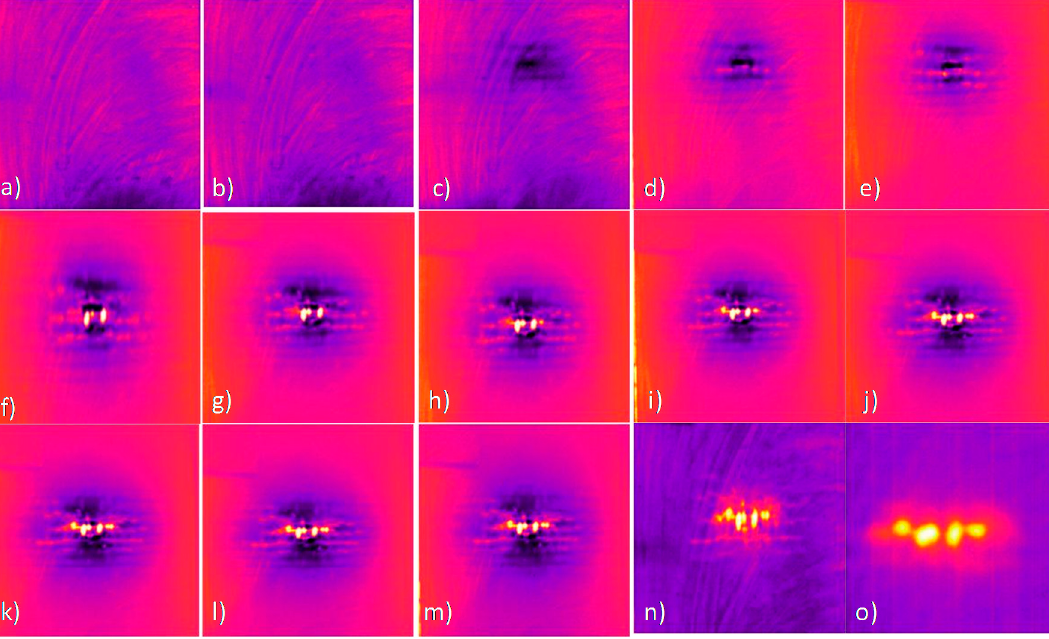
Figure 14. Some thermal images taken with SC6800 camera at different time instants during impact of a GFRP specimen. ( a ) t = 0 s; ( b ) t = 0.001 s; ( c ) t = 0.002 s; ( d ) t = 0.003 s; ( e ) t = 0.004 s; ( f ) t = 0.005 s; ( g ) t = 0.006 s; ( h ) t = 0.007 s; ( i ) t = 0.008 s; ( j ) t = 0.009 s; ( k ) t = 0.010 s; ( l ) t = 0.011 s; ( m ) t = 0.012 s; ( n ) t = 0.026 s; ( o ) t = 0.60